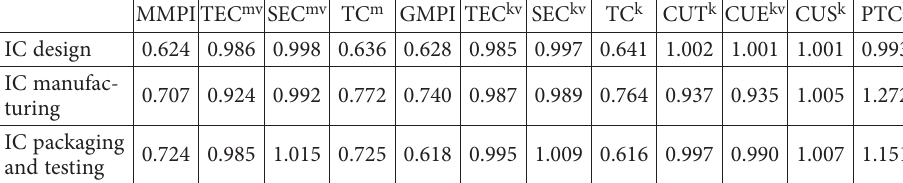
Table 7. The decompositions of GMPI and MMPI from 2010 to 2011